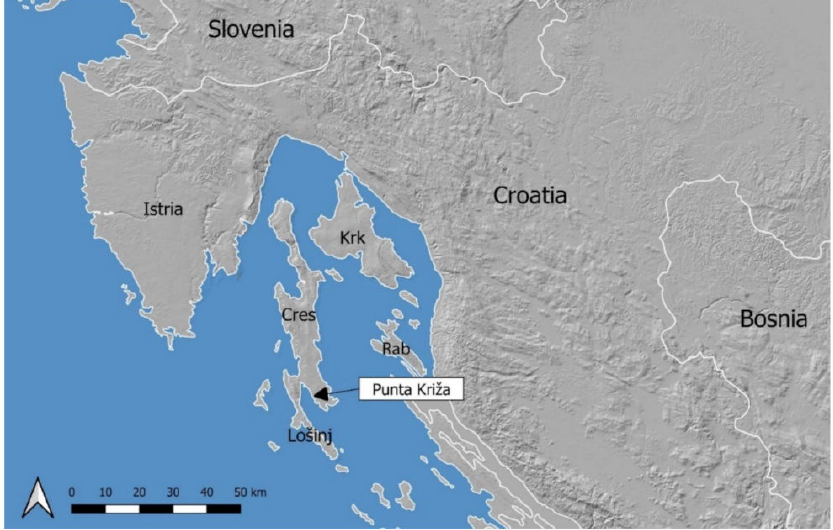
Figure 1. Map of the northern Adriatic indicating the location of the case study area on Punta Križa (at the tip of the arrow).